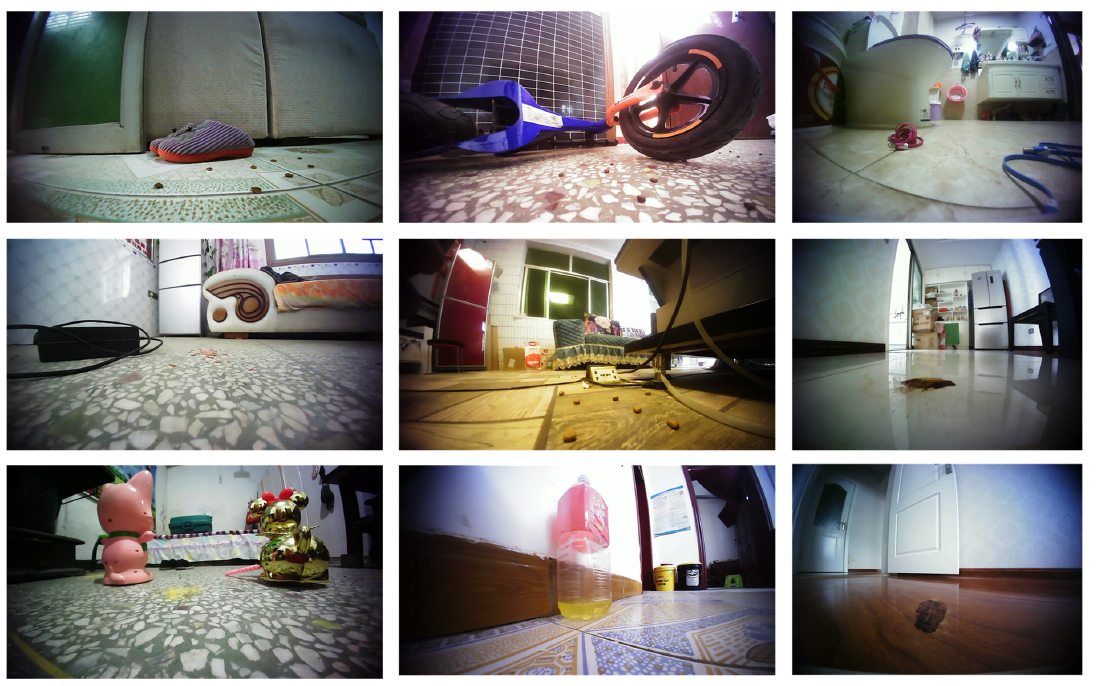
Figure 4. Several examples of images of indoor noncleanable hazardous obstacles such as shoes, kids’ toys, power strips, power cords, pet feces, and oil bottles.